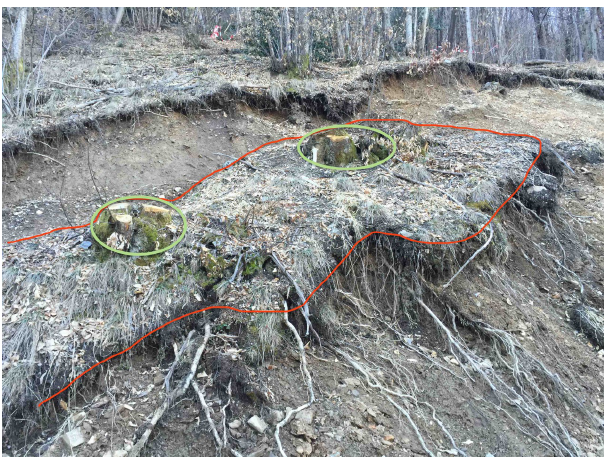
Figure 12. Example of a weak zone in a forested area showing isolated tree stumps with a root system that behaved as a stiff island during the opening of a gap in a weak zone in between root systems of adjacent trees.